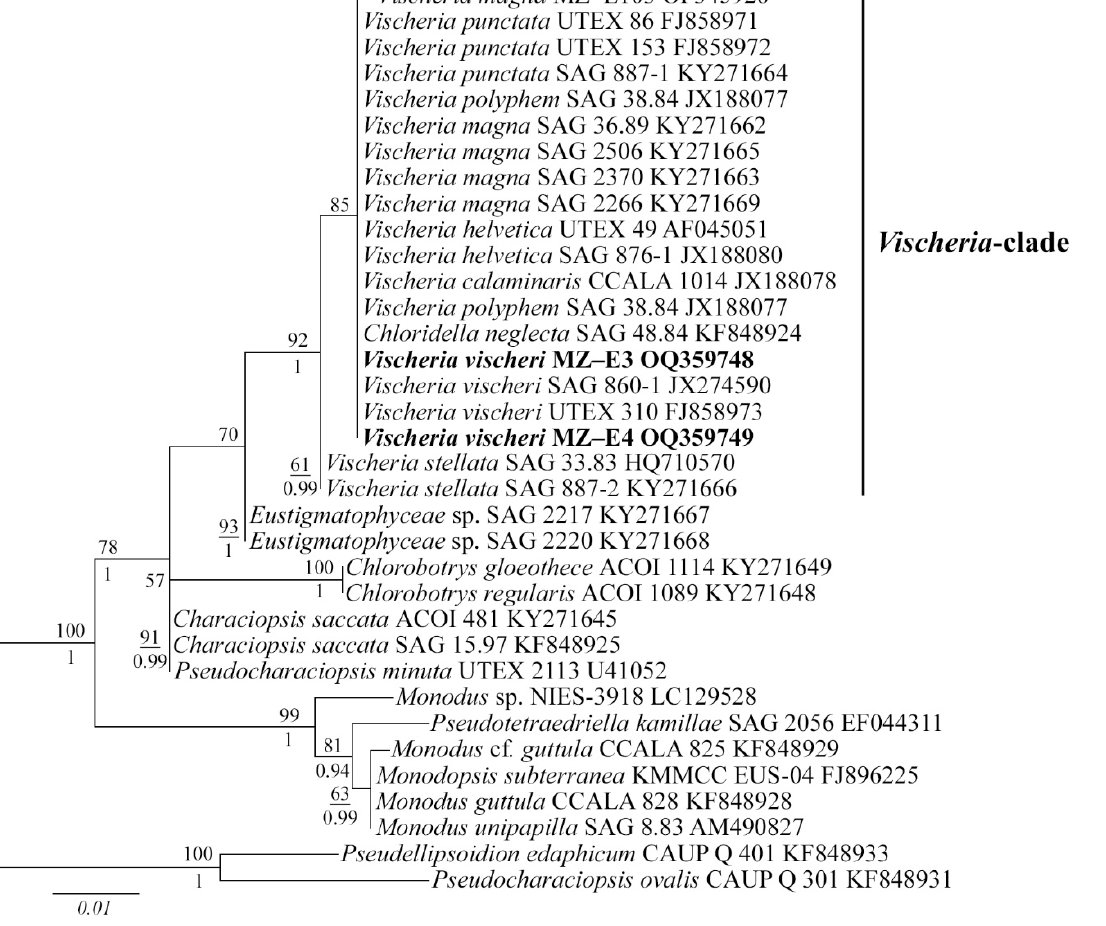
Figure 2. Phylogenetic position of new Vischeria strains (indicated in bold) based on Maximum Likelihood from an alignment of 35 sequences and 477 characters (partial 18S rRNA gene). Values above the horizontal lines are bootstrap support from ML analyses (values below 50 are not shown). Values under the horizontal lines are Bayesian posterior probabilities (values below 0.9 are not shown). Strain numbers (if available) and GenBank numbers are indicated for all